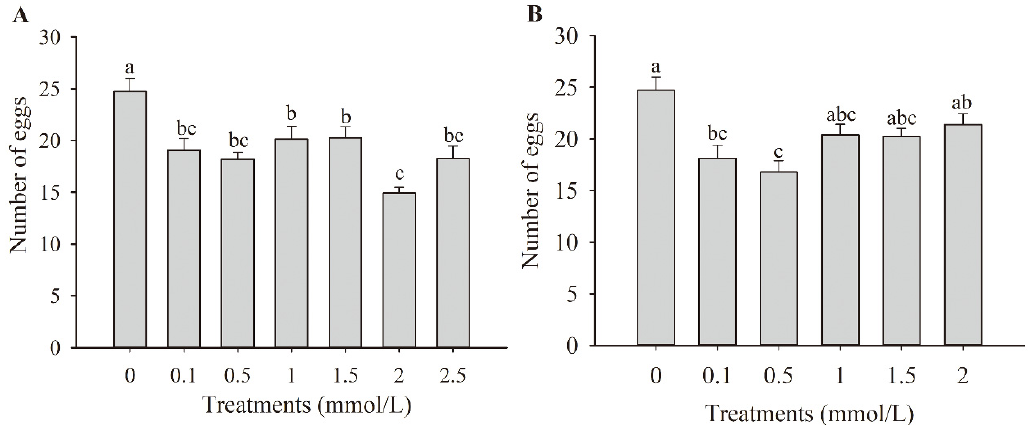
Figure 1. Effects of jasmonic acid ( A ) and ethylene ( B ) treatments on Frankliniella occidentalis oviposition in faba bean plants. Data are shown as mean ± standard error ( n = 15). Different letters above the bars indicate significant differences among different treatments ( p < 0.05; one-way analysis of variance, Tukey’s test).